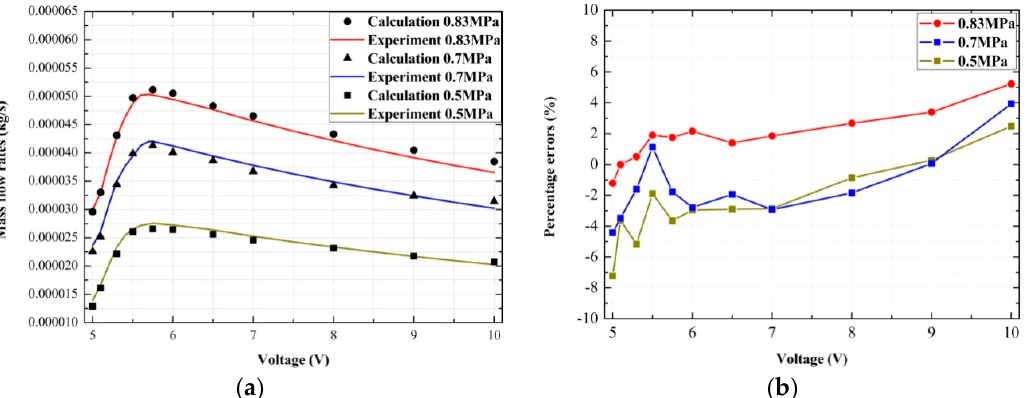
.  M 5 with different driving voltages and their errors: ( a ) Mass flow M with different driving voltages and their errors: ( a ) Mass 5